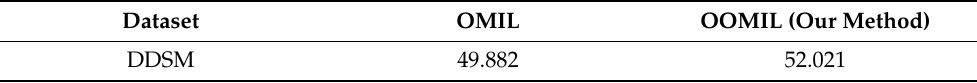
Table 4. Test accuracy comparison results for OMIL and OOMIL (our)